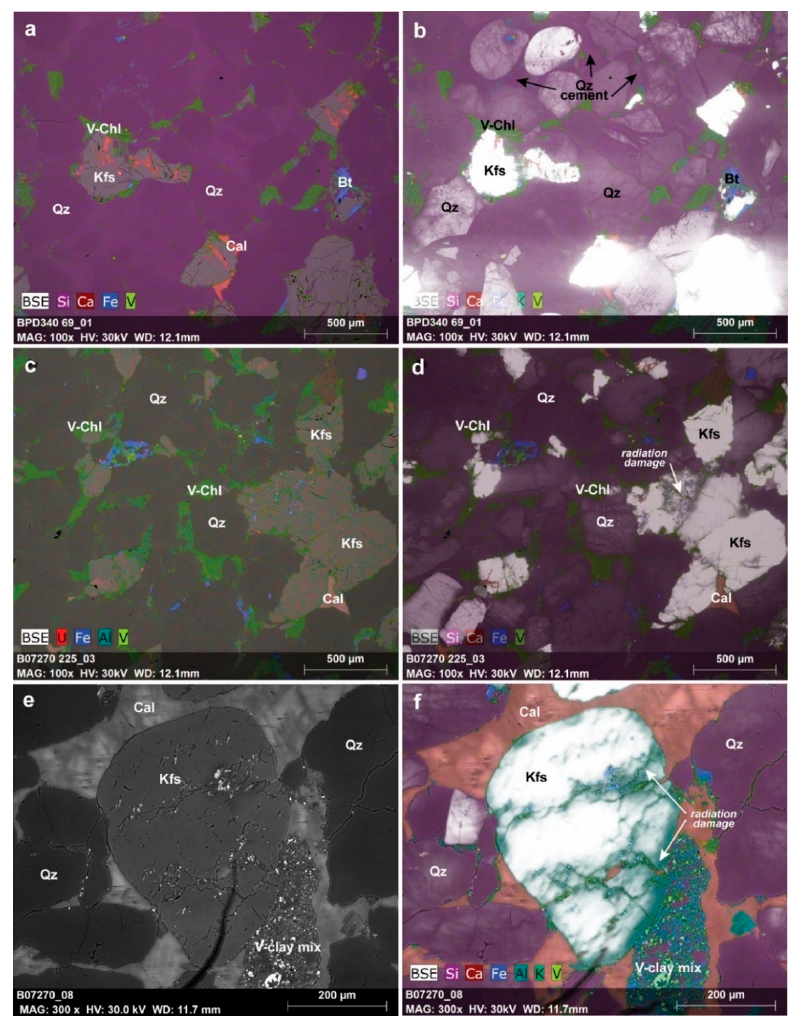
Figure 11. Paired BSE-EDS and CL/SEM micrographs showing different lithic clast types and radiation-induced damage, ( a , b ) lithic clasts composed of re-deposited sandstone with inherited quartz cement, pore space composed of V-chlorite; ( c , d ) immature, angular lithic clasts of granitic origin with pervasive V-chlorite and minor U-minerals associated with radiation-induced damaged K-feldspar; ( e , f ) calcite-cemented sandstone engulfing radiation-induced damaged K-feldspar.